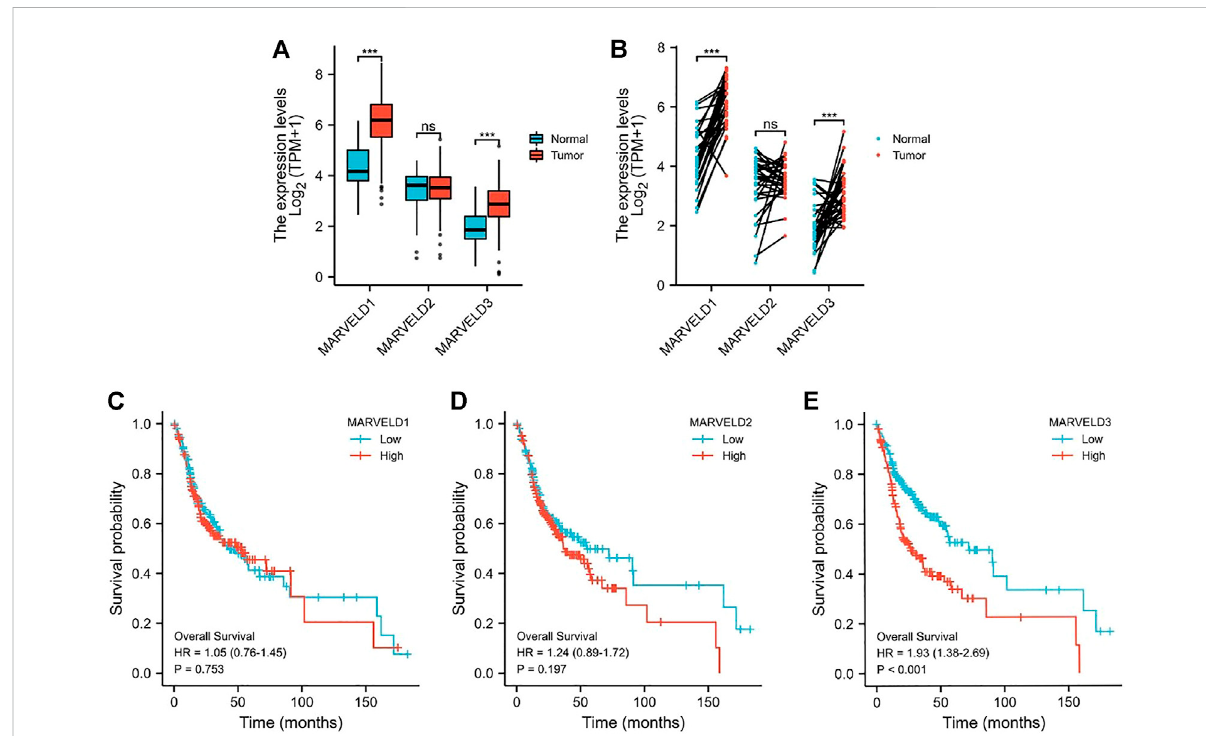
FIGURE 1 The MARVELDs expressions and survival analysis in OSCC. (A) Differential expression analysis of MARVELDs in non-paired samples of OSCC patients. (B) DifferentialexpressionanalysisofMARVELDsinpairedsamplesofOSCCpatients. (C – E) K-Msurvivalcurvesoftheassociationsbetween MARVELDs expressions and overall